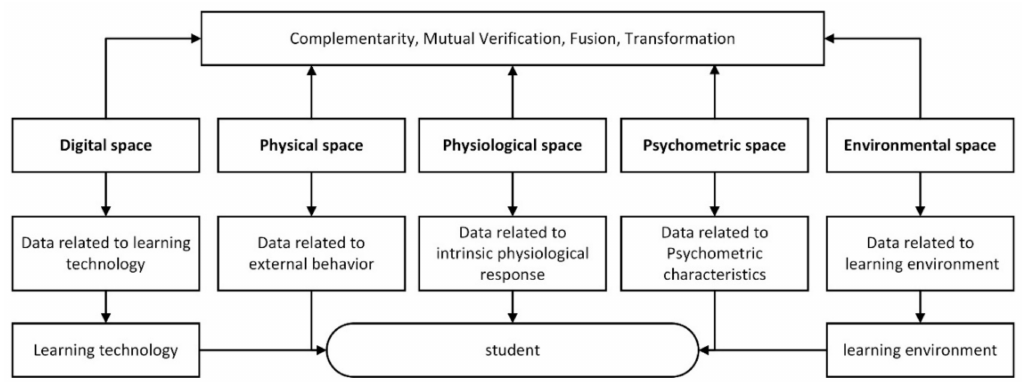
Figure 3. The classification framework of the multimodal